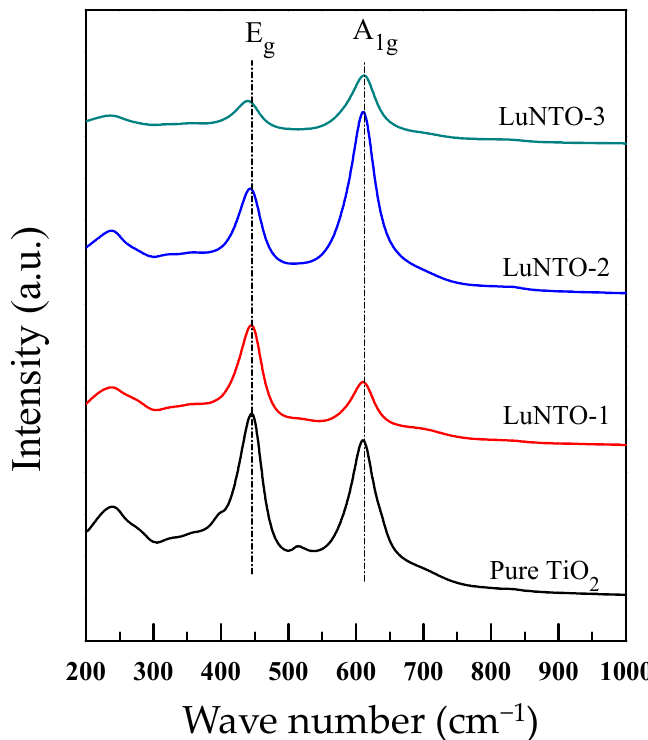
Figure 5. Raman spectra of TiO 2 and LuNTO ceramics with various co ‐ doping concentrations.